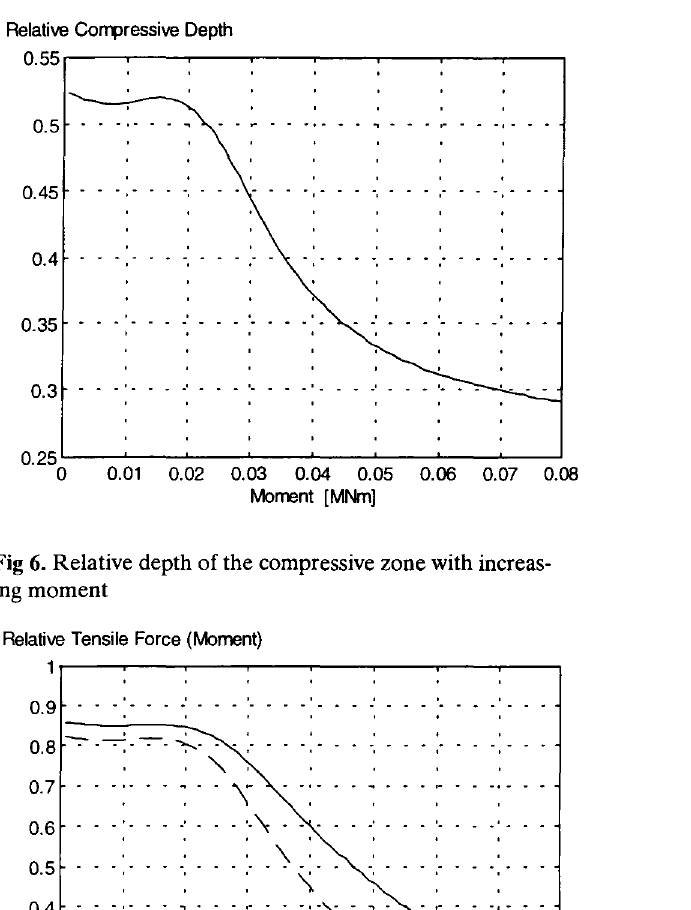
Fig 7. Relative influence of tensile concrete in overall ten sion action with increasing moment - horizontal force action - - - - moment action